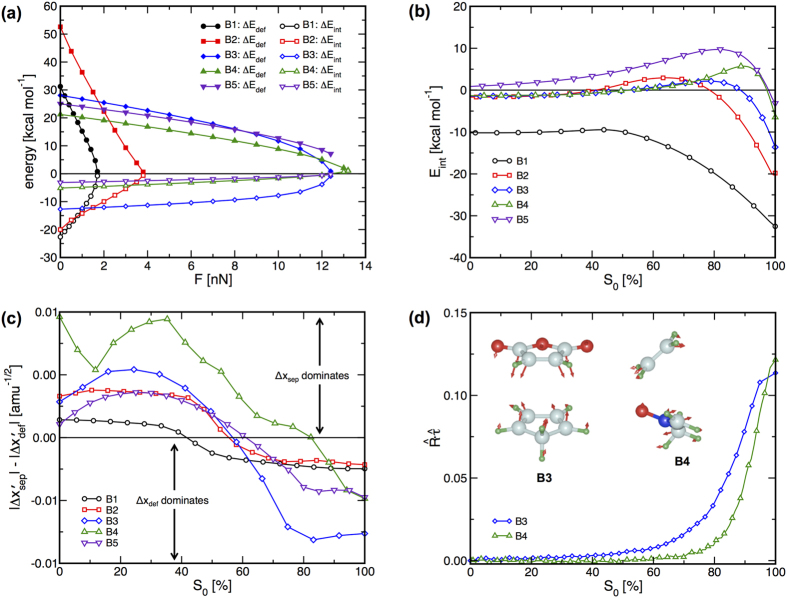
Force-dependent energetic and structural details for reactions B1 through B5.(a) ΔEdef and ΔEint versus F. (b) Interaction energy, Eint, between the reacting components along S0 relative to the infinitely separated reactants. (c) Comparison of rates at which Δxsep and Δxdef change along S0. In each case, S0 is represented as a percentage of the distance from the reactants (0%) to the TS (100%). (d) Projection of F onto S0 for reactions B3 and B4. The reactant complexes for reactions are B3 and B4 are shown with arrows indicating the force-induced motions of atoms in those structures, with longer arrows indicating larger motions.